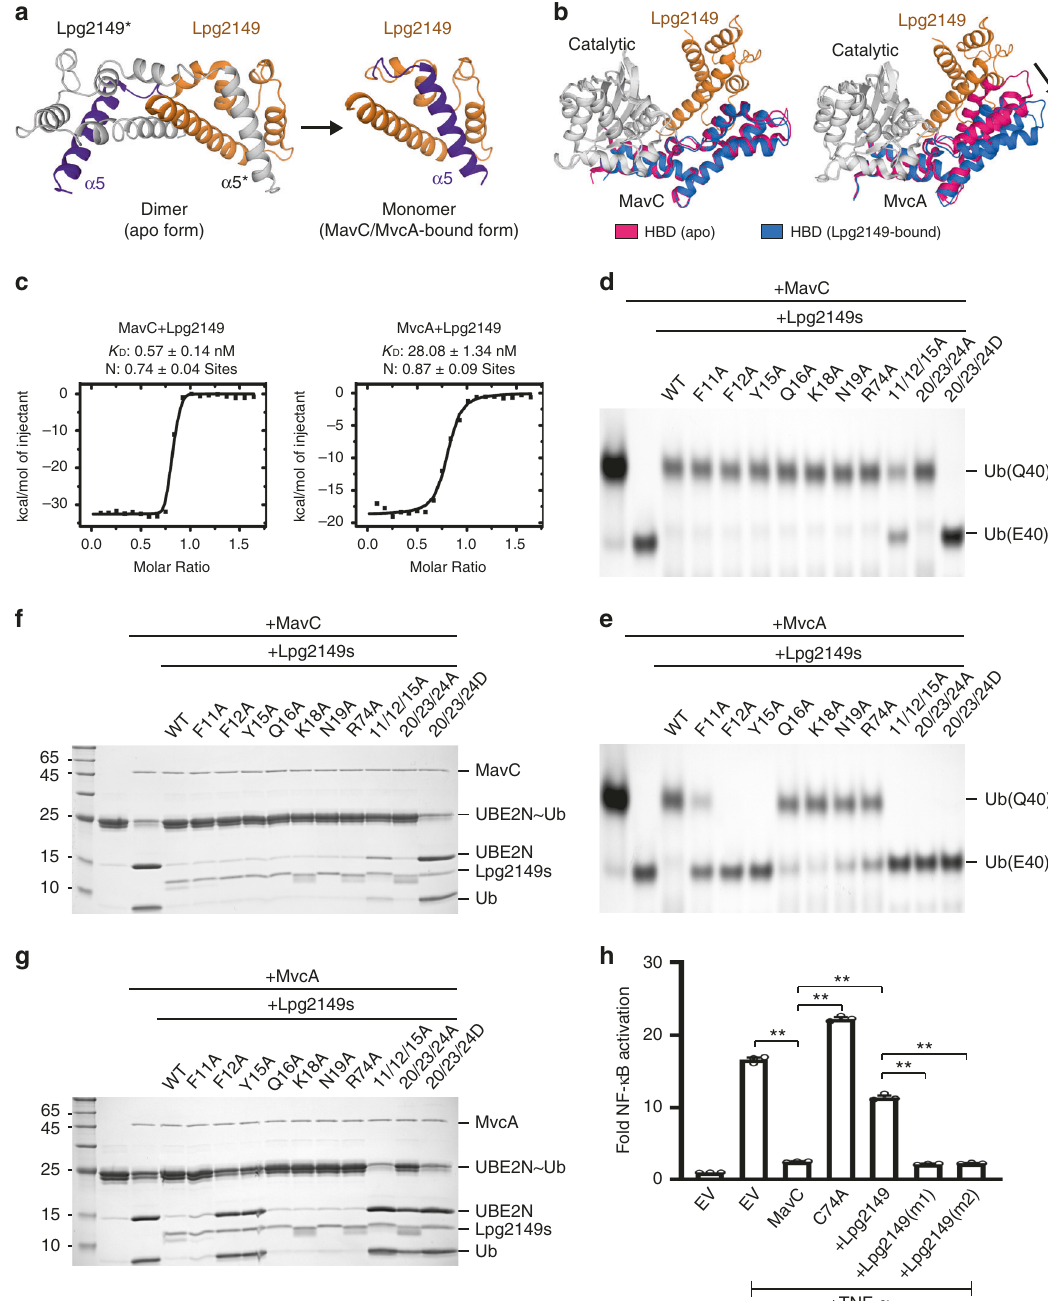
Fig. 6 Unique inhibiting strategies of Lpg2149 against MavC and MvcA. a The dimer-to-monomer transition of Lpg2149 upon binding to MavC/MvcA. b Conformational changes of MavC (left) and MvcA (right) in their apo and Lpg2149-bound states. The Catalytic domain is the reference point of structural superimpositions for both proteins. c Isothermal titration calorimetry (ITC) assays to test binding of Lpg2149 to MavC (left) and MvcA (right). K D s and N s are mean ±SEM ( n = 2). d , e Inhibition activities of various Lpg2149 mutants for d MavC- and e MvcA-mediated Ub deamidation. f , g Inhibition activities of various Lpg2149 mutants for f MavC- and g MvcA-mediated UBE2N~Ub deubiquitination. h Lpg2149 antagonized MavC ’ s inhibitory effect on NF- к B activation in cells, and the mutations of Lpg2149 (m1: F11D/F12D/Y15D; m2: V20D/L23D/L24D) decreased the antagonism. Plasmids encoding Lpg2149 (or its mutants) and MavC were co-transfected with NF- к B luciferase reporter system plasmids. Cells were mock-treated or treated with TNF- α . The luciferase activities were measured for the activation of NF- к B reporter (see details in Methods). Data presented are means±SEM of three independent experiments. ** p <0.01, unpaired and two-tailed t test. Source data are provided as a Source Data fi le. Experiments in c – h were repeated independently three times with similar expected, Ub deamidation experiments show that most Lpg2149 analyzed their inhibition activities for both enzymes. Since single-point mutants can still fully inhibit MavC, and only a few Lpg2149 binds more strongly to MavC (Fig. 6c and Supplemen- triple mutants reduce the inhibition ef fi ciency (Fig. 6d). On the tary Fig. 6a), the mutations of Lpg2149 may have less effects on other hand, the same set of Lpg2149 mutants show considerable the inhibition reduction against MavC than that of MvcA. As